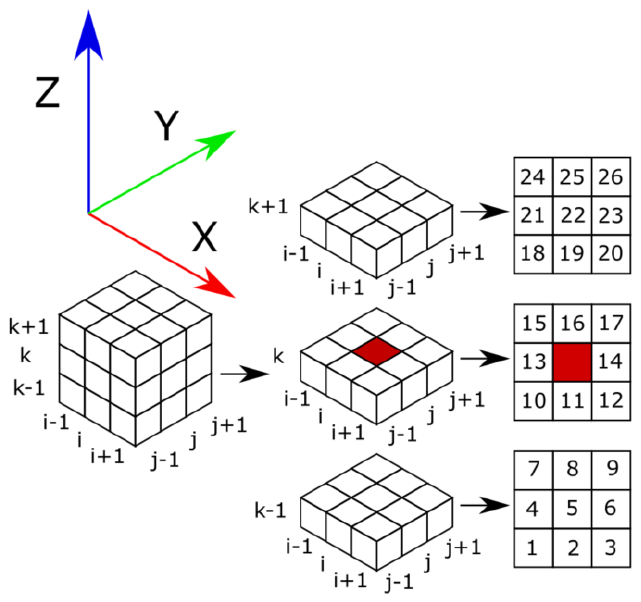
Figure 5. Voxel’s neighbours numbering. The numeration is organised by levels in the 𝒁 dimen- sion.